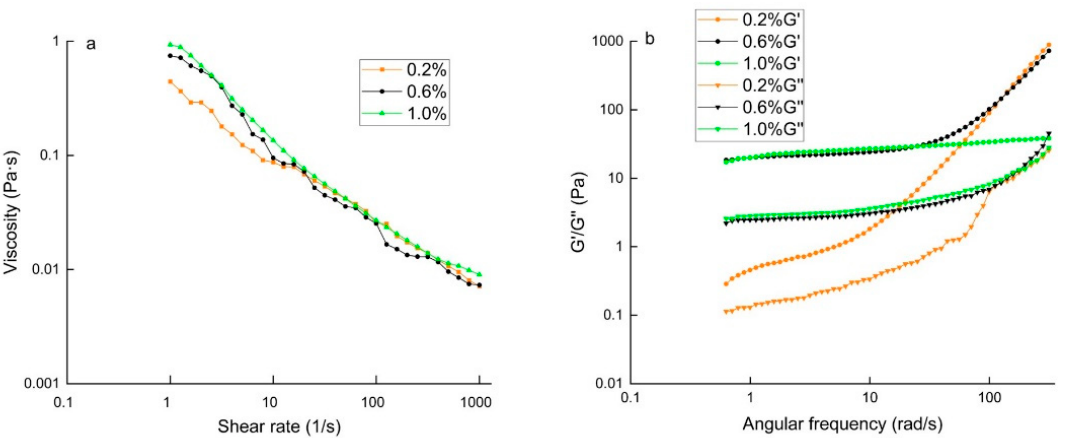
Figure 7. The viscosity of double-layer emulsions with various chitosan concentrations ( a ). Frequency dependence of the storage (G ′ ) and loss (G ″ ) moduli for double-layer emulsions with various chitosan concentrations ( b ).